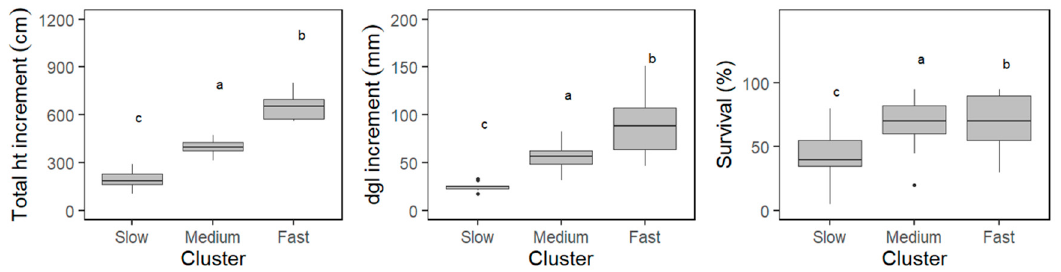
Figure 4. Variations in growth performances of clustered domesticated native species at the end of measurement period in 2018. In the boxplots, the thick horizontal line shows the median, the box extends to the upper and lower quartiles, the thin vertical lines indicate the nominal range and the small circles indicate points which lie outside of the nominal range. For a given graph, different letters denote significant differences among clustered species ( p < 0.05) using the Tukey’s HSD (Honest Significant Difference) test.